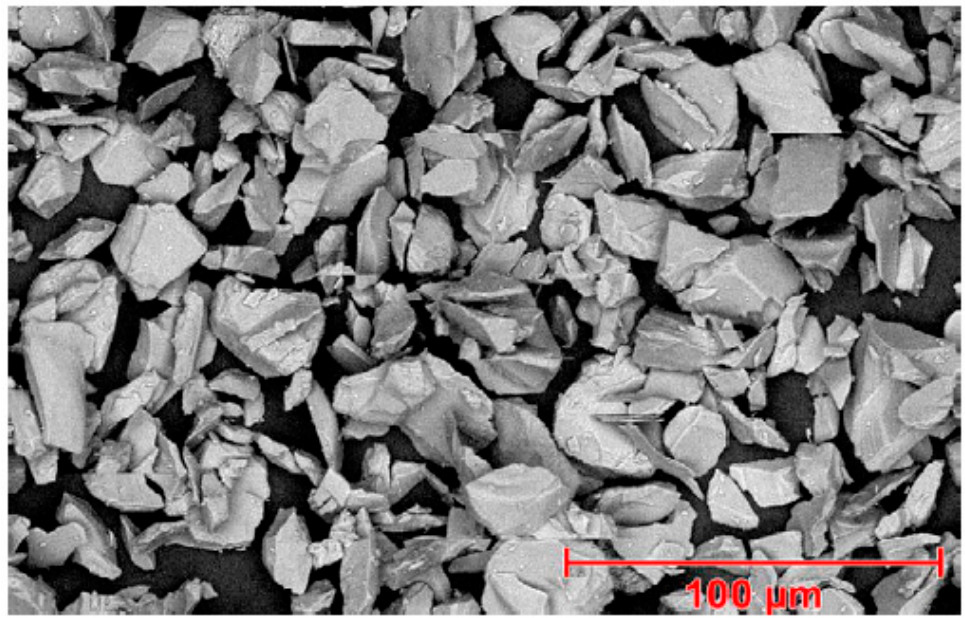
Figure 5. SEM photomicrographs (1000× of magnification) of Al 2 O 3. SiO 2 powder morphology [22].